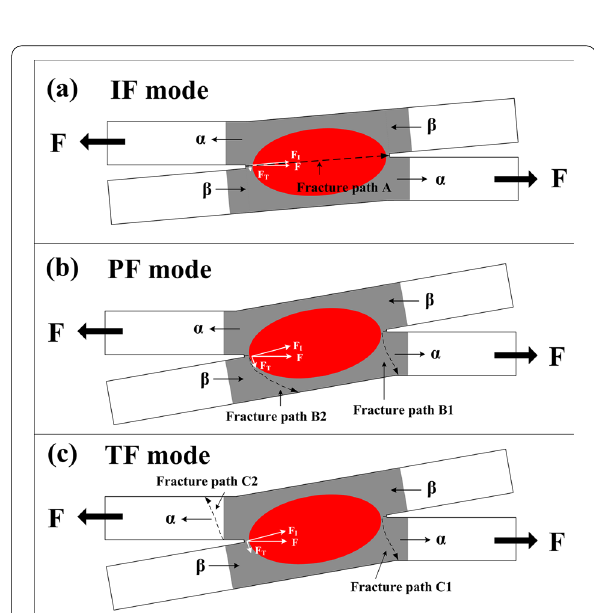
Figure 10 Schematics of failure mechanisms for ( a ) IF mode, ( b ) PF mode and ( c ) TF